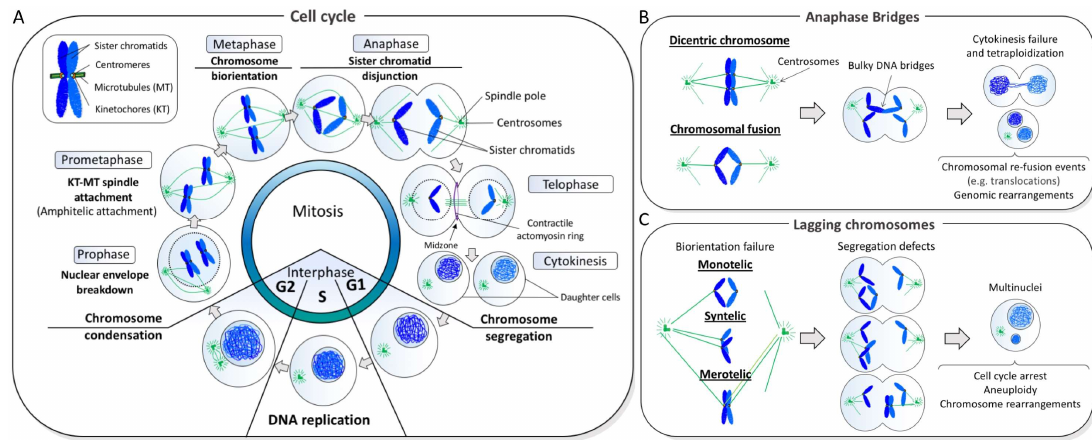
Figure 1. Normal and abnormal chromosome segregation. ( A ) In each cell division cycle, sister chromatid cohesion is established in S phase while DNA is being replicated. As cells enter mitosis, the duplicated DNAs begin to condense through a process driven by the condensin complex. During prometaphase-metaphase progression, kinetochores resided at the centromeric regions of chromatids attach to microtubules that emanate from the opposite centrosomes, leading to the alignment